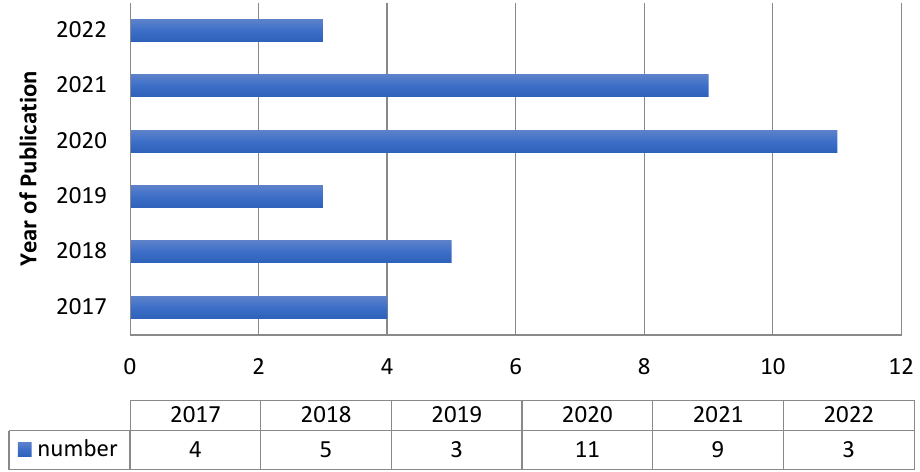
Figure 1. Summarized historically-distributed studies for adversarial perturbations and attacks on CAPTCHAs.